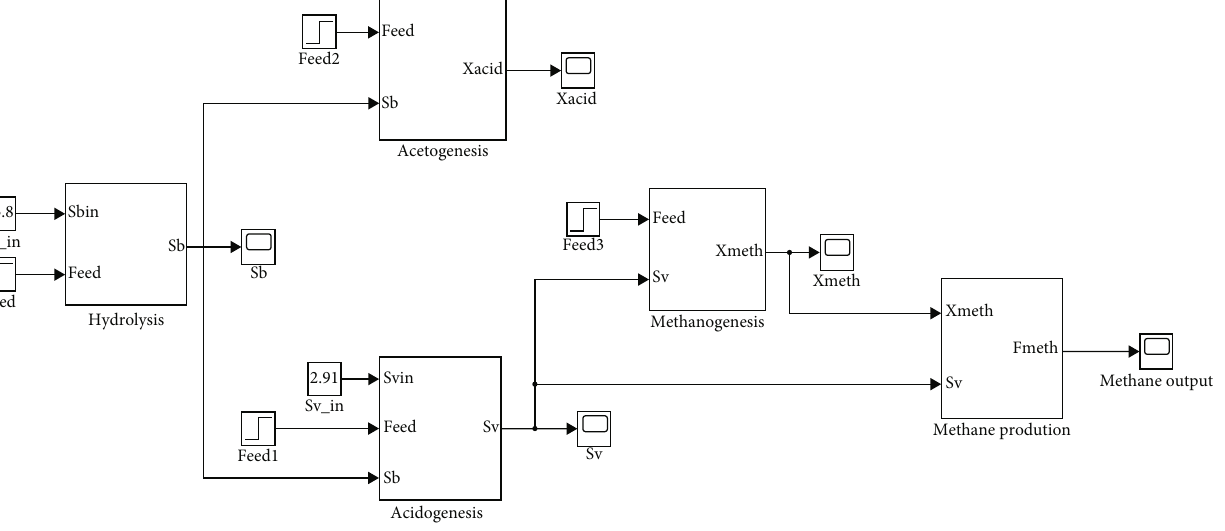
Figure 8: Complete Simulink model of AD.